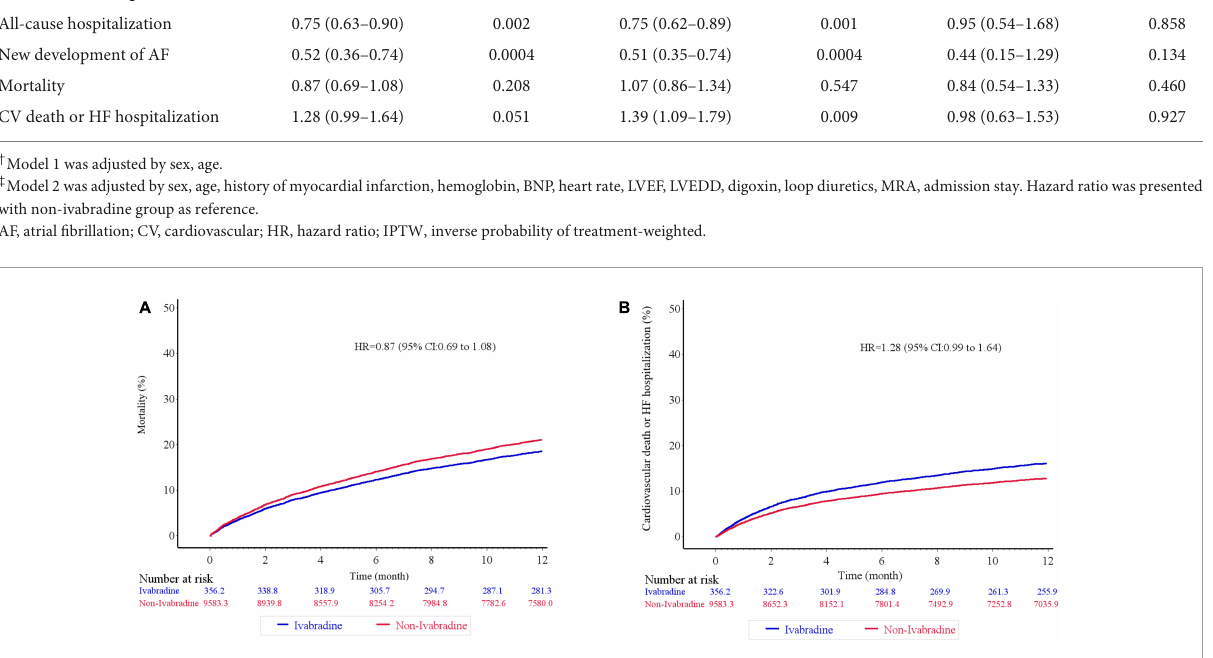
FIGURE4 Kaplan–Meier cumulative event curves of clinical outcomes. There was no significant difference in terms of mortality (A) , and the composite of cardiovascular death or heart failure hospitalization (B) between ivabradine and the non-ivabradine groups after inverse probability of treatment weighting analysis without further